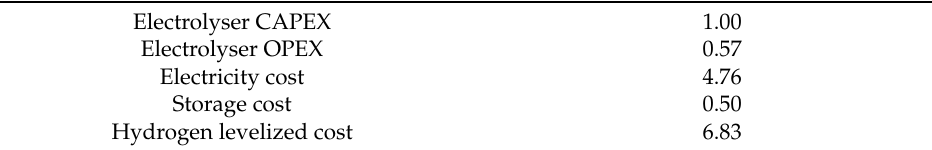
Table 4. Resultant costs (in NZD/kg H 2 ).